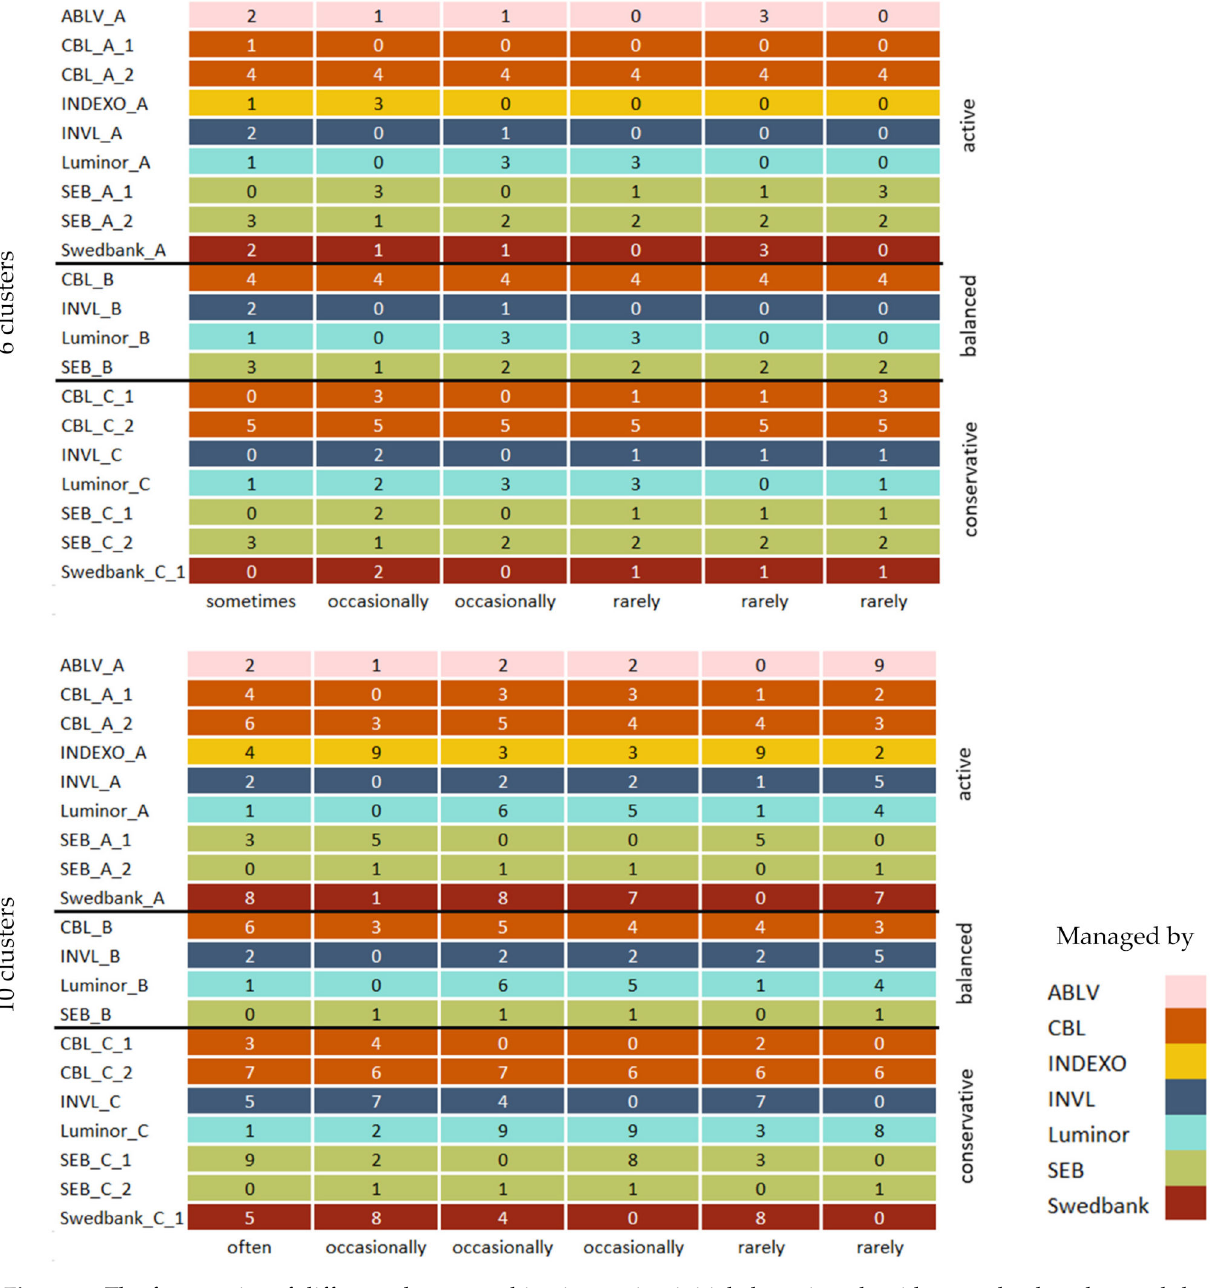
Figure 9. The frequencies of different cluster combinations using initial clustering algorithm results that clustered the dataset into six or ten clusters that also have silhouette scores above the mean